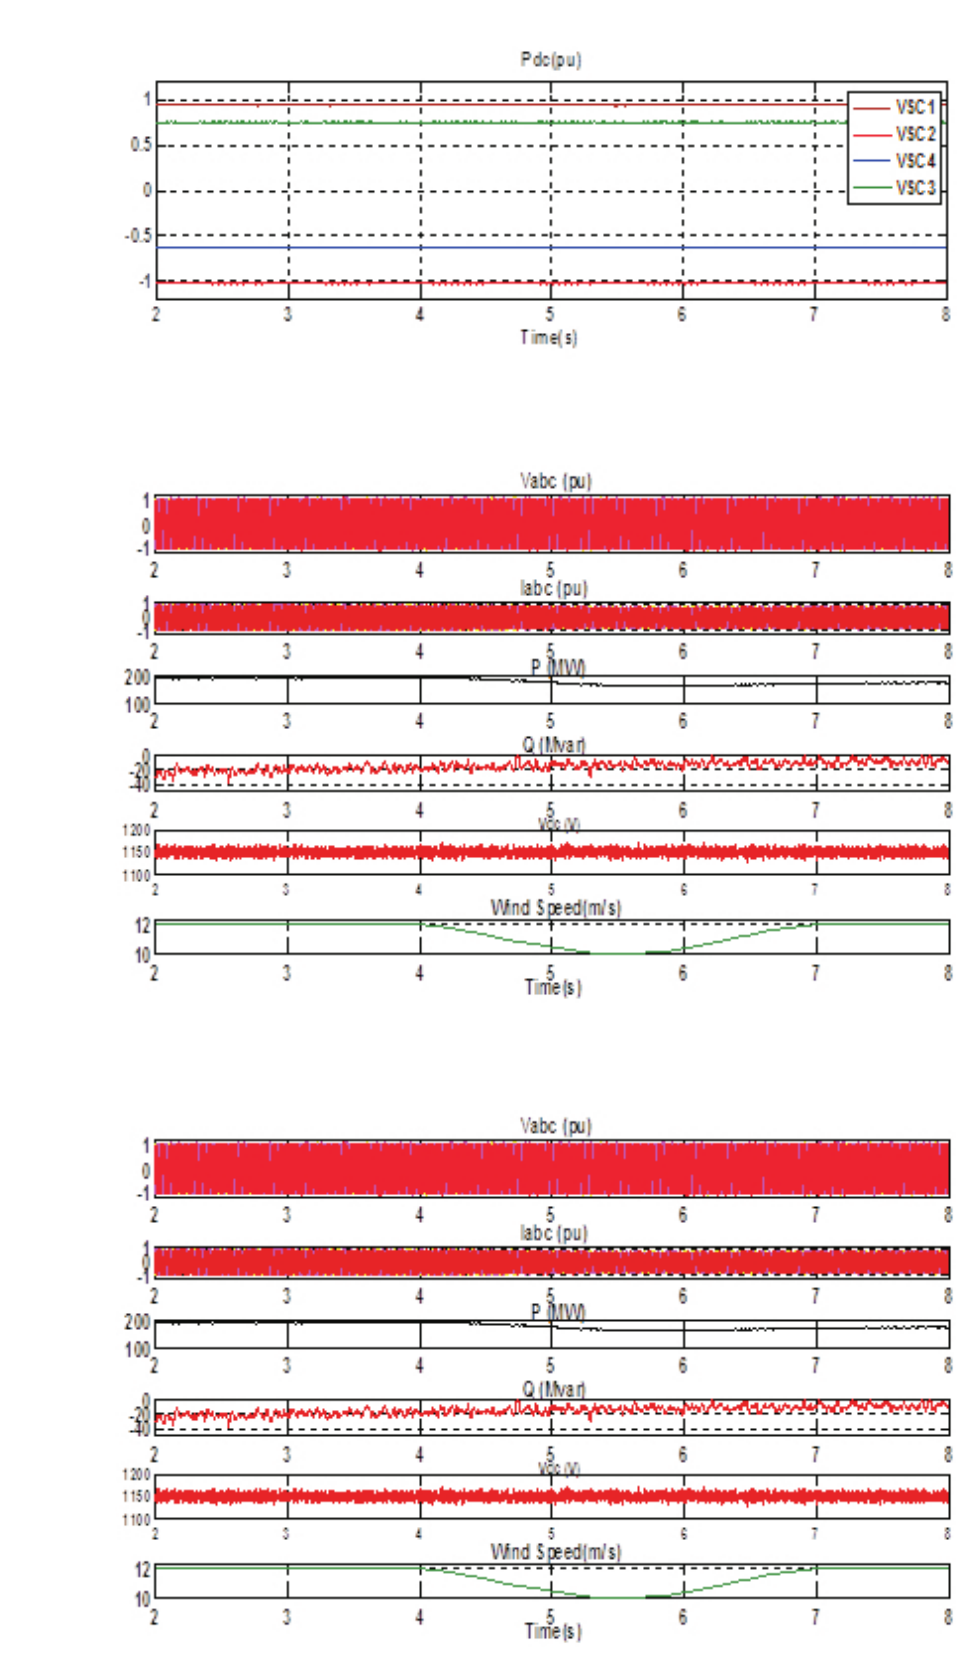
Figure 5: Dynamics of (a) VSC1 (b) VSC2 (c) VSC3 (d) VSC4 (e) DC powers and (f) Wind farm parameters for a change in wind